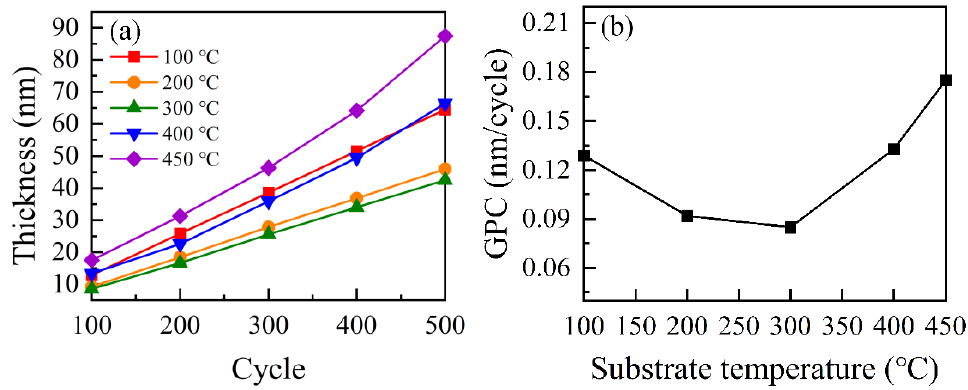
Figure 1. ( a ) The thickness of HfO 2 film increased linearly with the number of ALD reaction cycles in PEALD. ( b ) GPC in a temperature range of 100 – 450 °C.